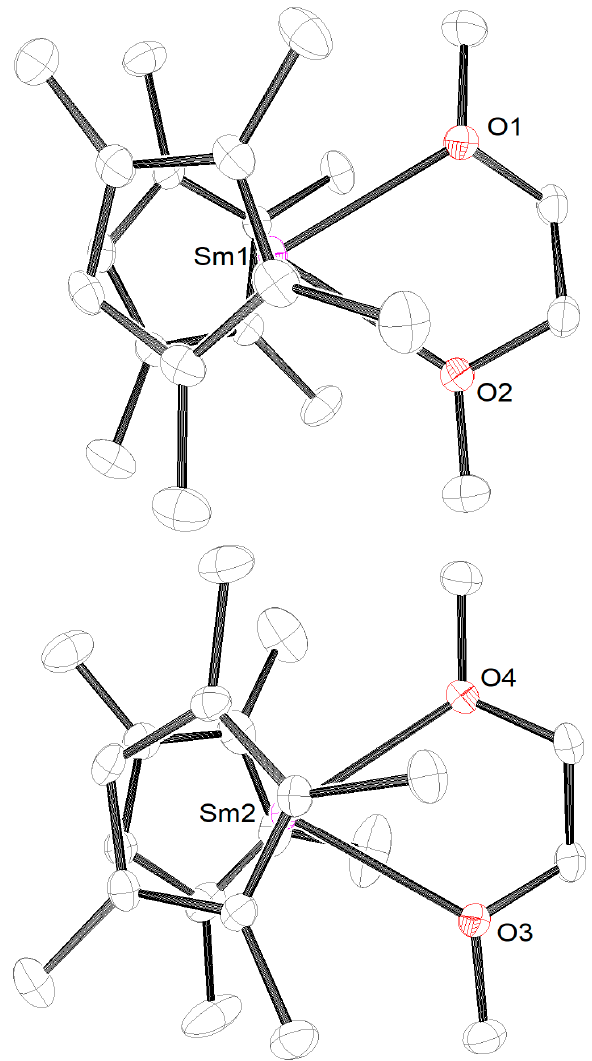
Figure 2. Top-down view of both molecules of (C 5 Me 4 H) 2 Sm(DME), 2, in the asymmetric unit. For clarity, hydrogen atoms are not shown.